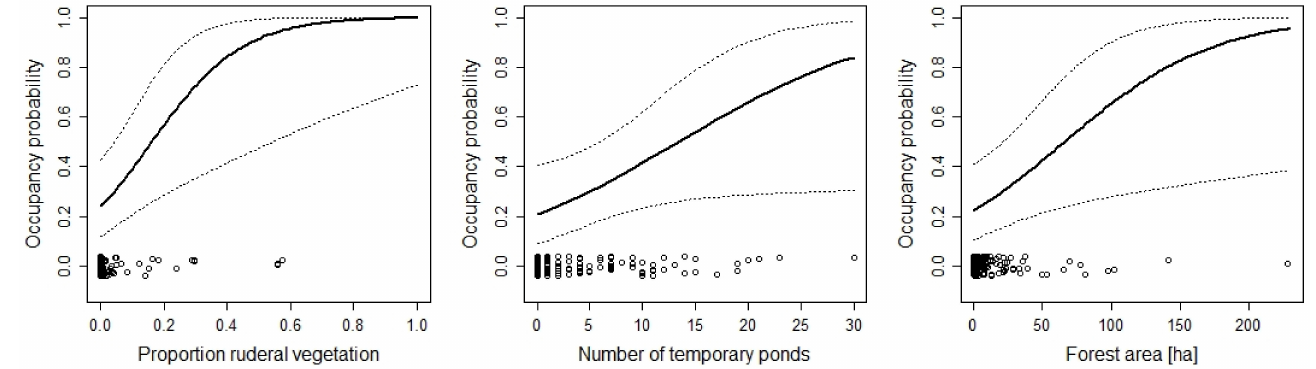
Figure 3. The effect of the number of temporary ponds, the percentage of the area within a site covered with ruderal vegetation within a site, and the area of forest on the occupancy probability of Bombina variegata . For additional explanations, see the caption of Figure